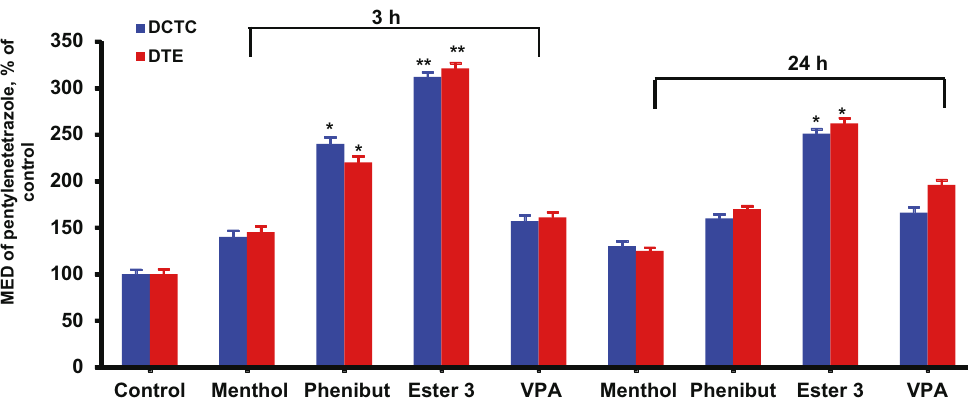
Figure 1: Anticonvulsant activity of ester 3, L - menthol, phenibut, and VPA against PTZ - induced seizures in mice at 3 and 24 h after oral administration. Values are given as mean ± SEM, n = 5 mice; for all groups p < 0.01 compared with the control; * p < 0.05 and ** p < 0.01 compared with VPA.